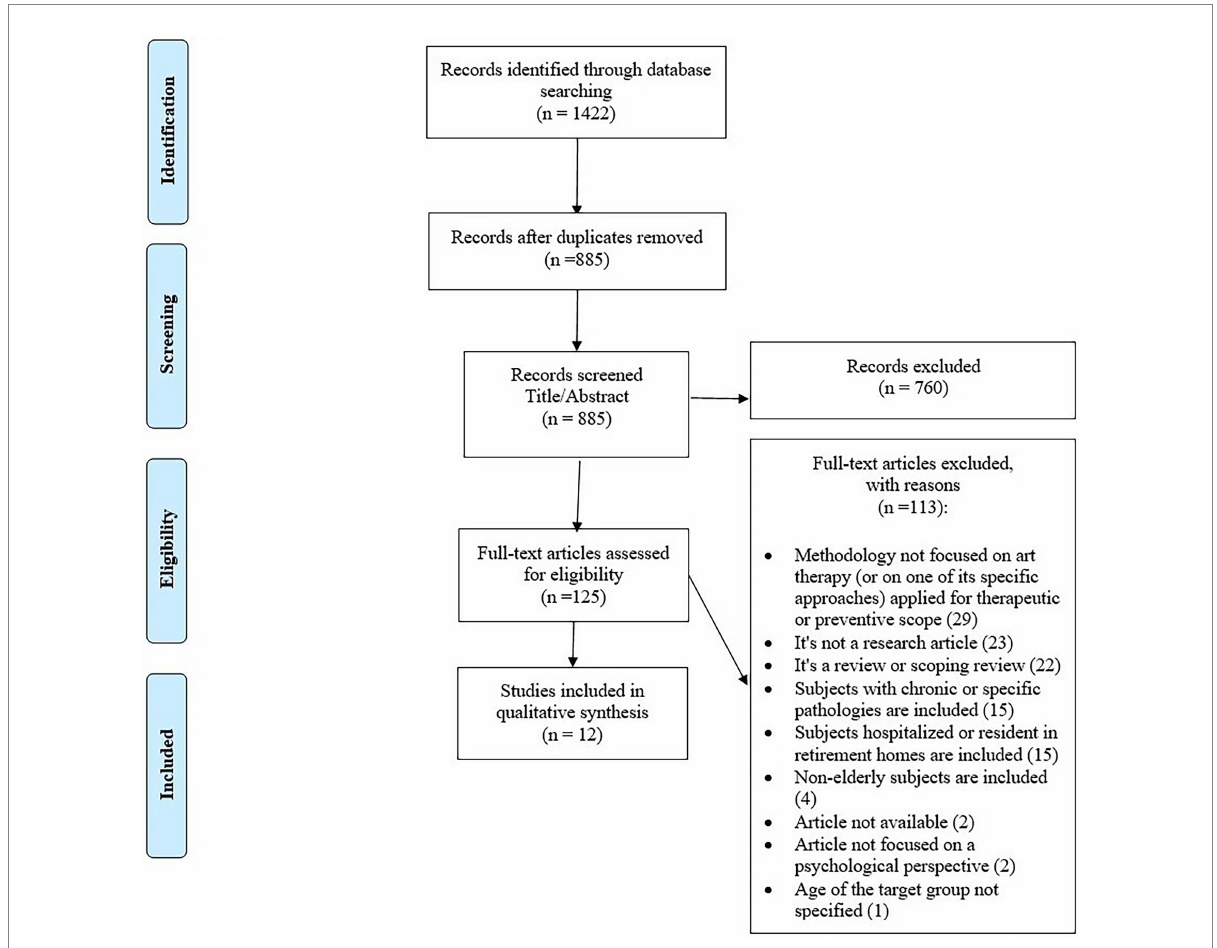
FIGURE 1 The PRISMA flow chart for reporting the study screening